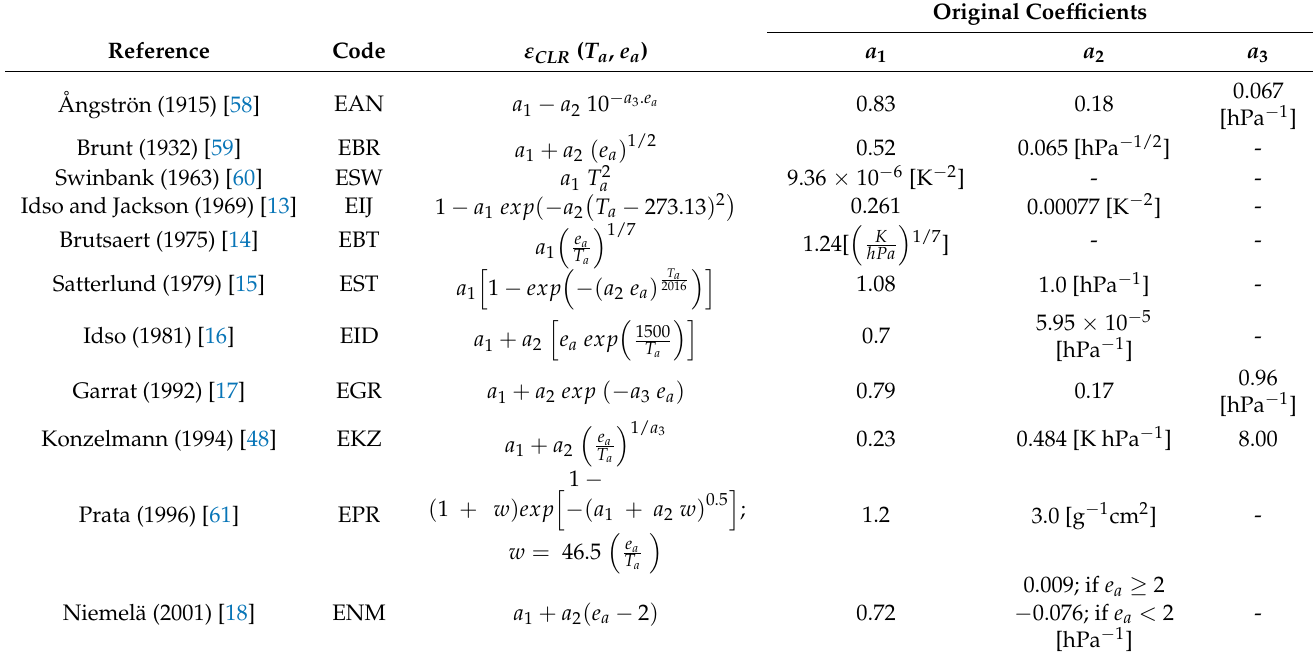
Table 1. Equations for atmospheric emissivity under clear sky conditions, ε CLR ( T a , e a ), and original coefficients. T a is the air temperature (K) and e a is the water vapor pressure (hPa).